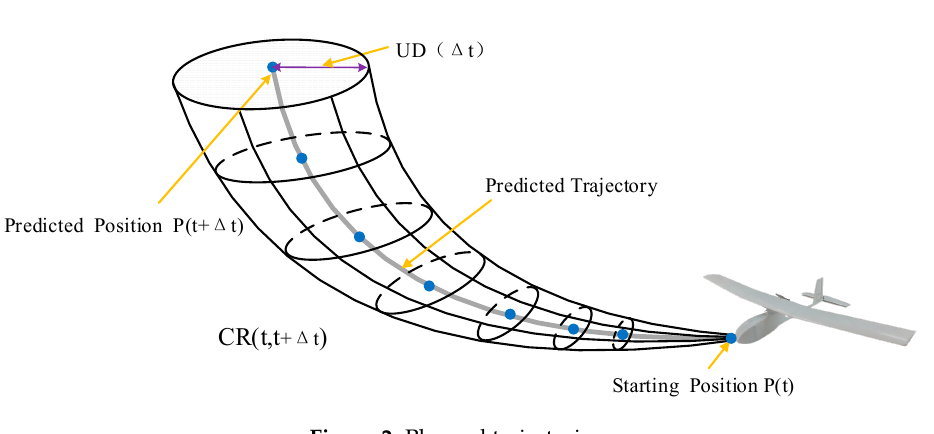
Figure 2. Planned trajectories.